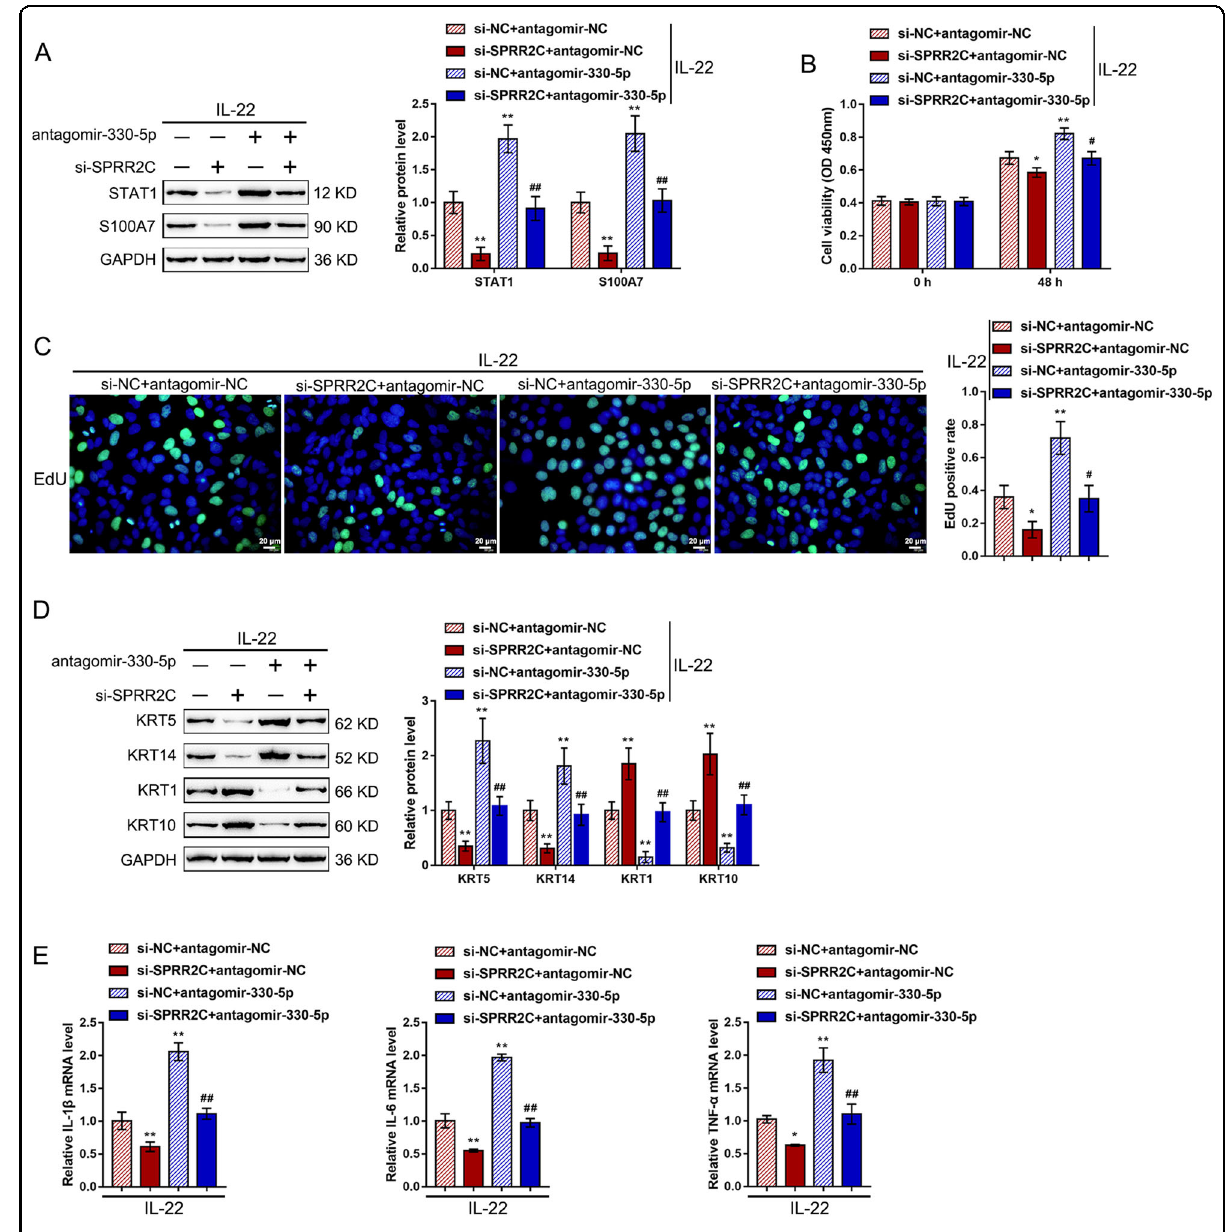
Fig. 6 Dynamic effects of lncRNA SPRR2C and miR-330 on STAT1 and S100A7 and IL-22-induced HaCaT cells. HaCaT cells were cotransfected with si-SPRR2C and antagomir-330-5p under L-22 stimulation and examined for ( A ) the protein levels of STAT1 and S100A7 by immunoblotting; B the cell viability by MTT assays; C DNA synthesis by EdU assays; D the protein levels of KRT5/14/1/10 by immunoblotting; E and the mRNA expression levels of IL-1 β , IL-6, and TNF- α by real-time PCR. * P < 0.05, ** P < 0.01, compared to the control group; # P < 0.05, ## P < 0.01, compared to the si-NC + antagomir-330-5p